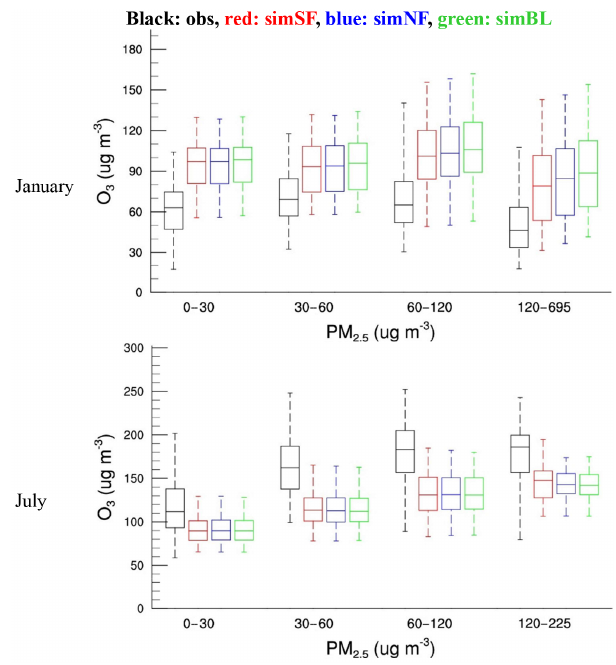
Figure 3. Observed and simulated surface O 3 concentration against PM 2 . 5 concentration (O 3 is daily 1h maximum of monitoring sites over China – unit: µgm − 3 ; PM 2 . 5 is the daily average of those site – unit: µgm − 3